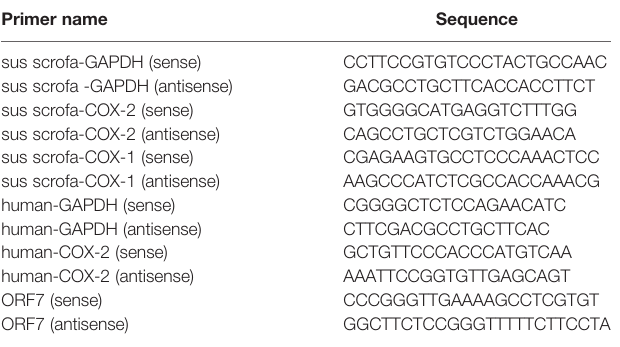
TABLE 4 | Quantitative RT-PCR primers.